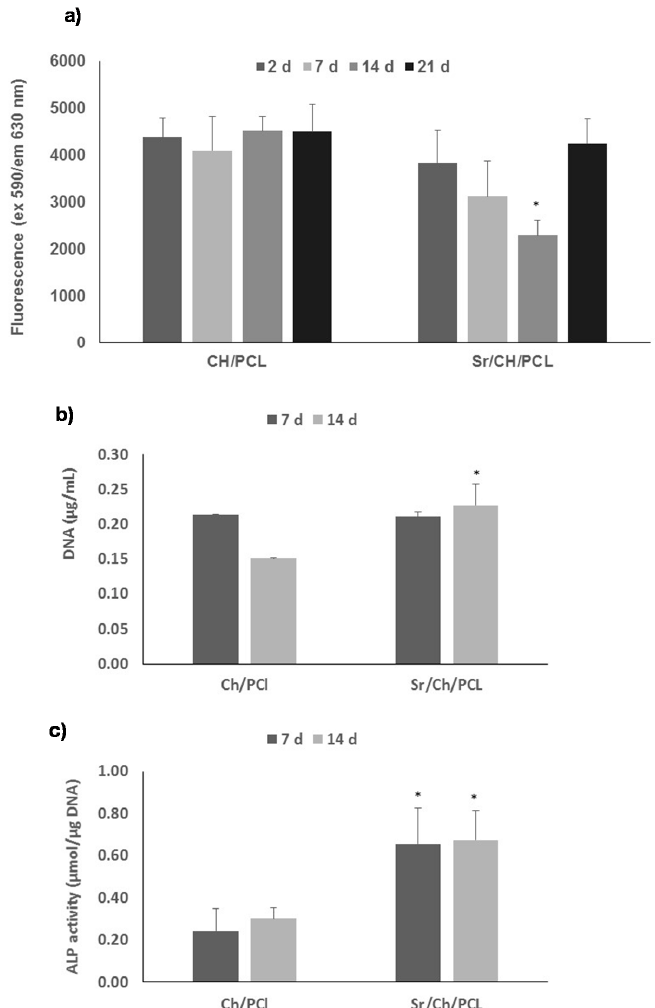
Figure 9. ( a ) Cell proliferation results obtained in AB assay of hBMSCs culture directly on test materials over a period of 21 days; ( b ) DNA ( μ g/mL) in cell lysate over a period of 14 days; ( c ) ALP/DNA activity over a period of 14 days. Results are the mean ± sd ( n = 4). Asterisks (*) indicate a significant difference comparing blank and Sr(II) samples at the same time (* p < 0.05). Ch: chitosan;